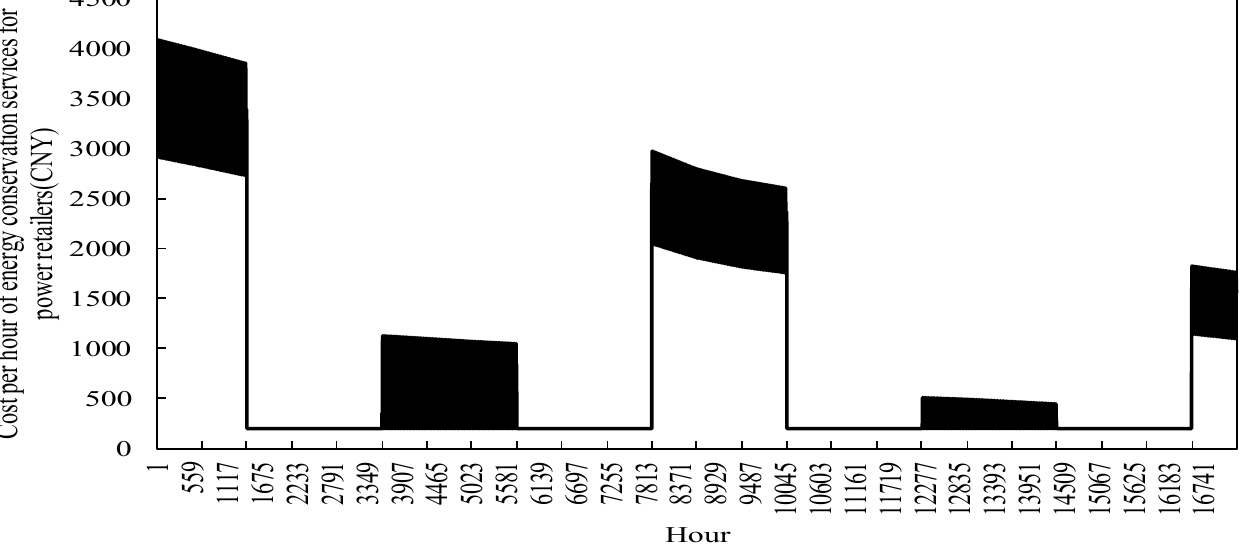
Figure 17. The change of energy conservation service cost per hour in power retailers.